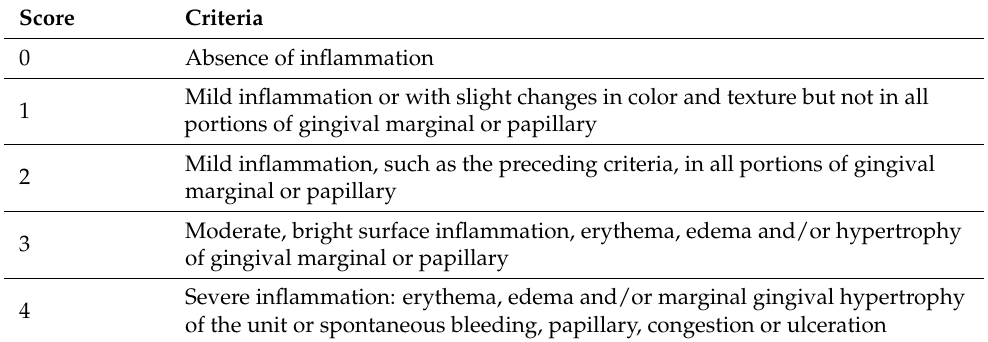
Table 2. The grading system of gum status for the (MGI)